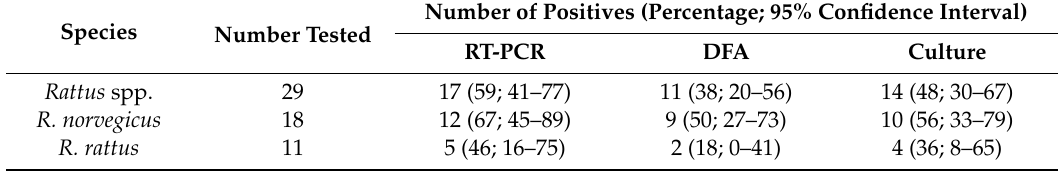
Table 1. Summary of Leptospira detection in rat